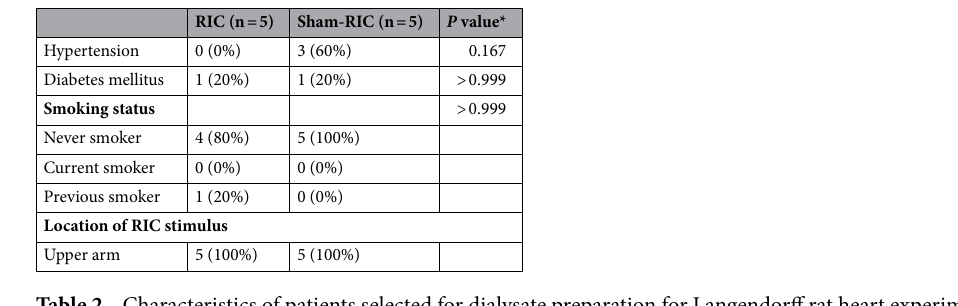
Table 2. Characteristics of patients selected for dialysate preparation for Langendorff rat heart experiments. Values are number (proportion). RIC, remote ischemic conditioning. * P value between the RIC and sham-RIC